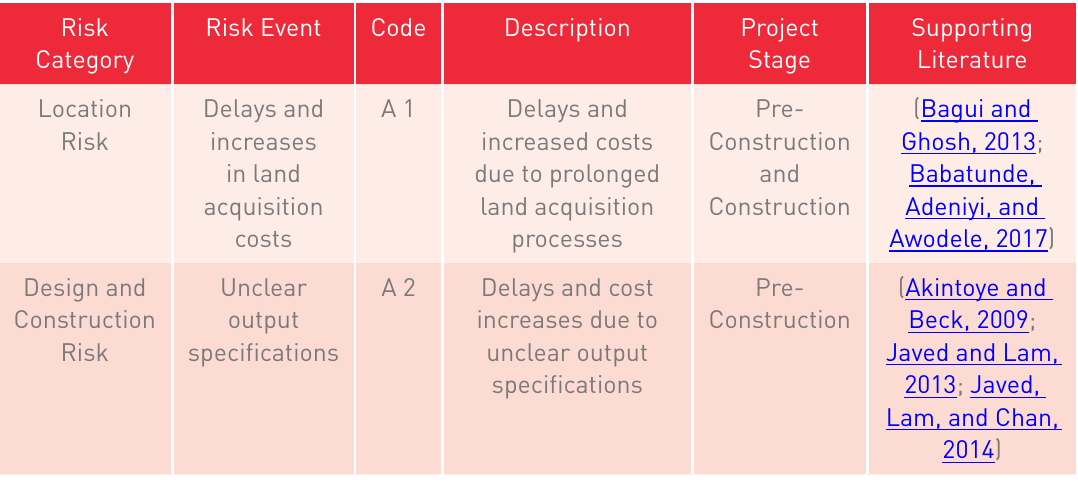
Risk categories and events in toll